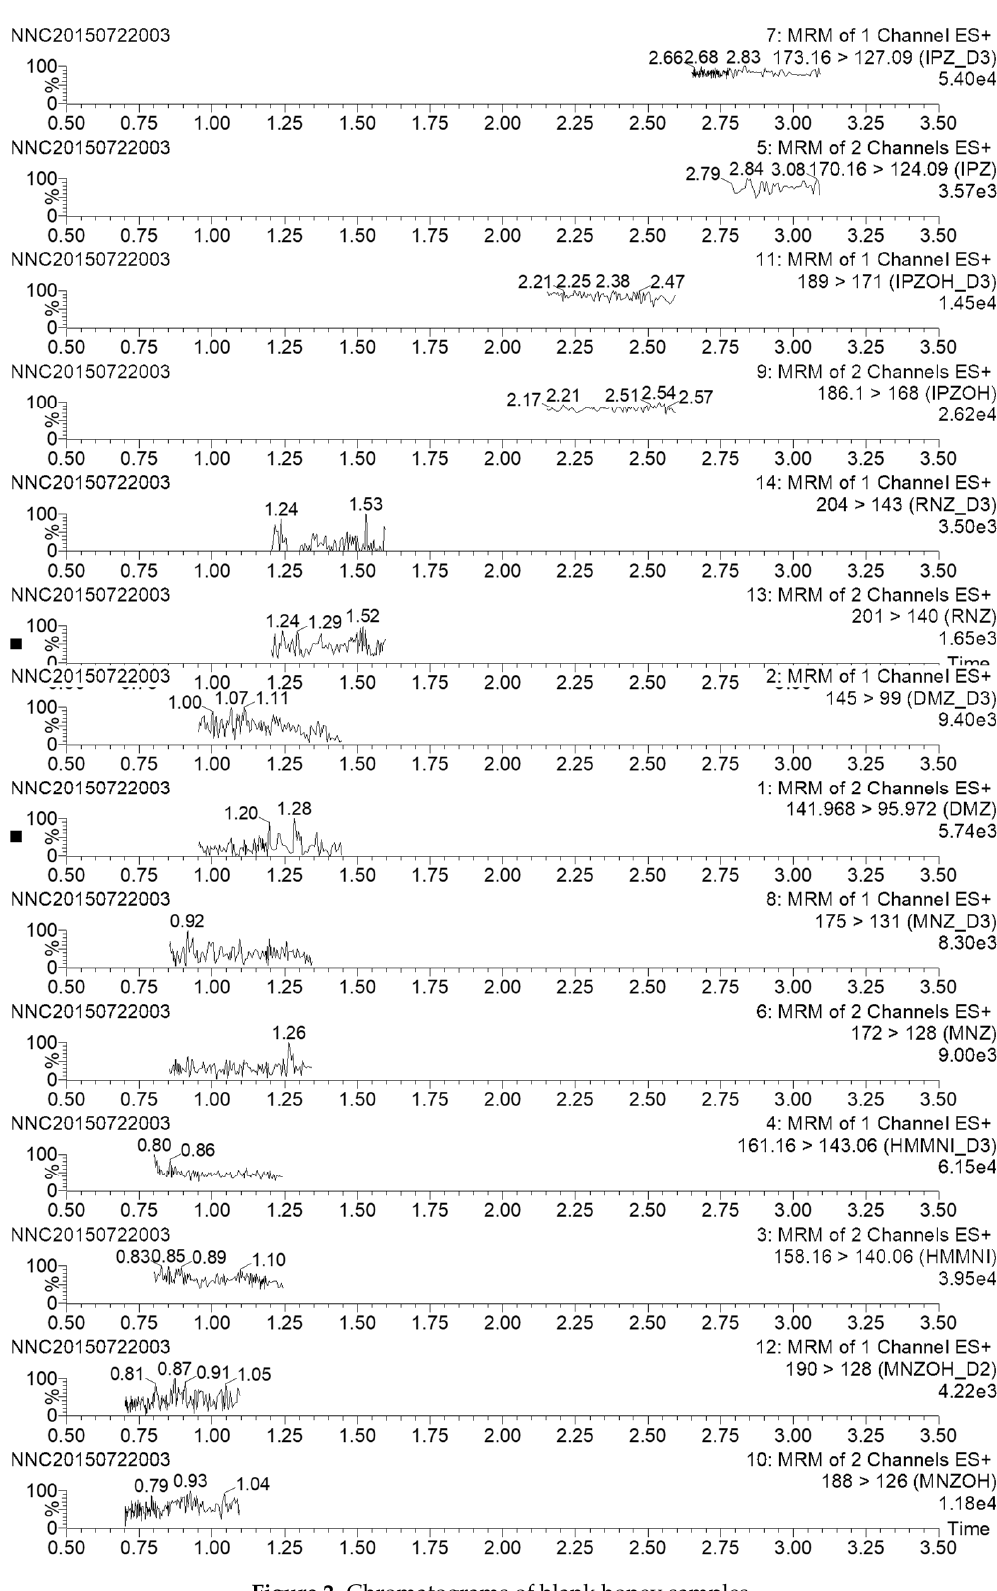
Figure 2. Chromatograms of blank honey samples.